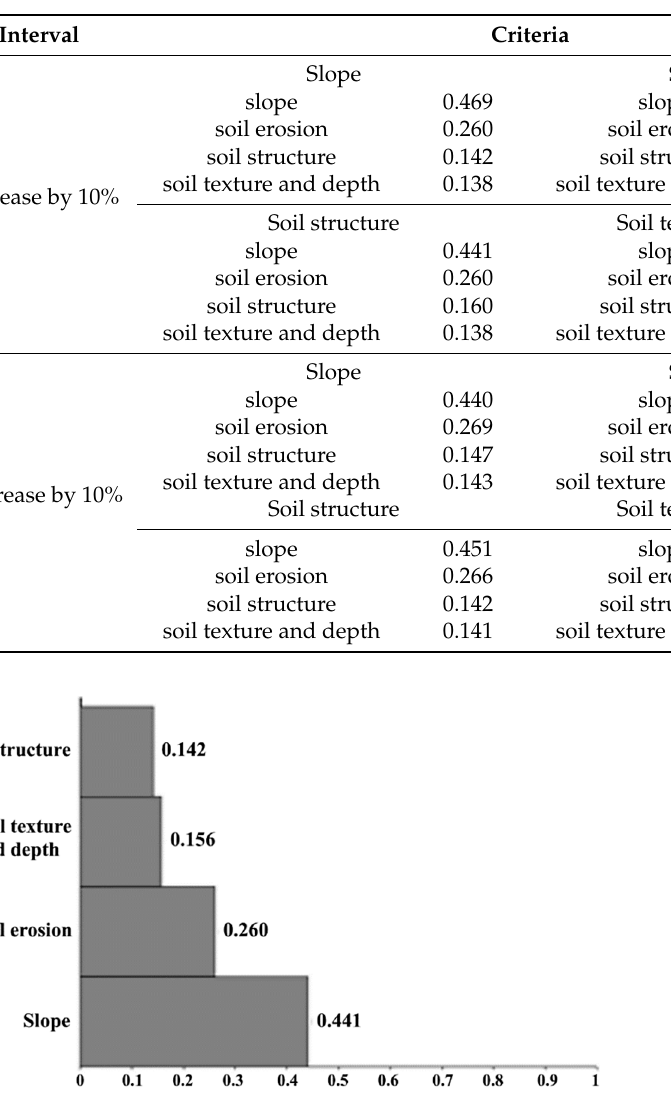
Figure 8. Sensitivity analysis linkage with soil texture and depth.